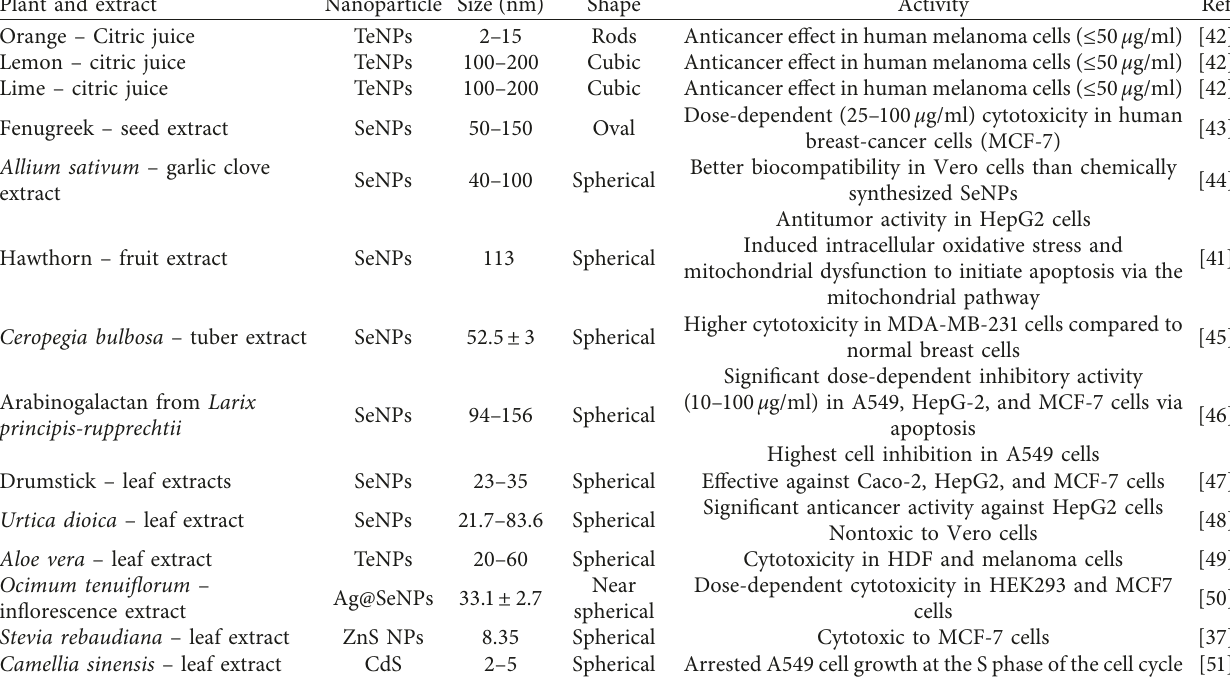
Table 1: Green synthesized chalcogen and chalcogenide nanoparticles with anticancer